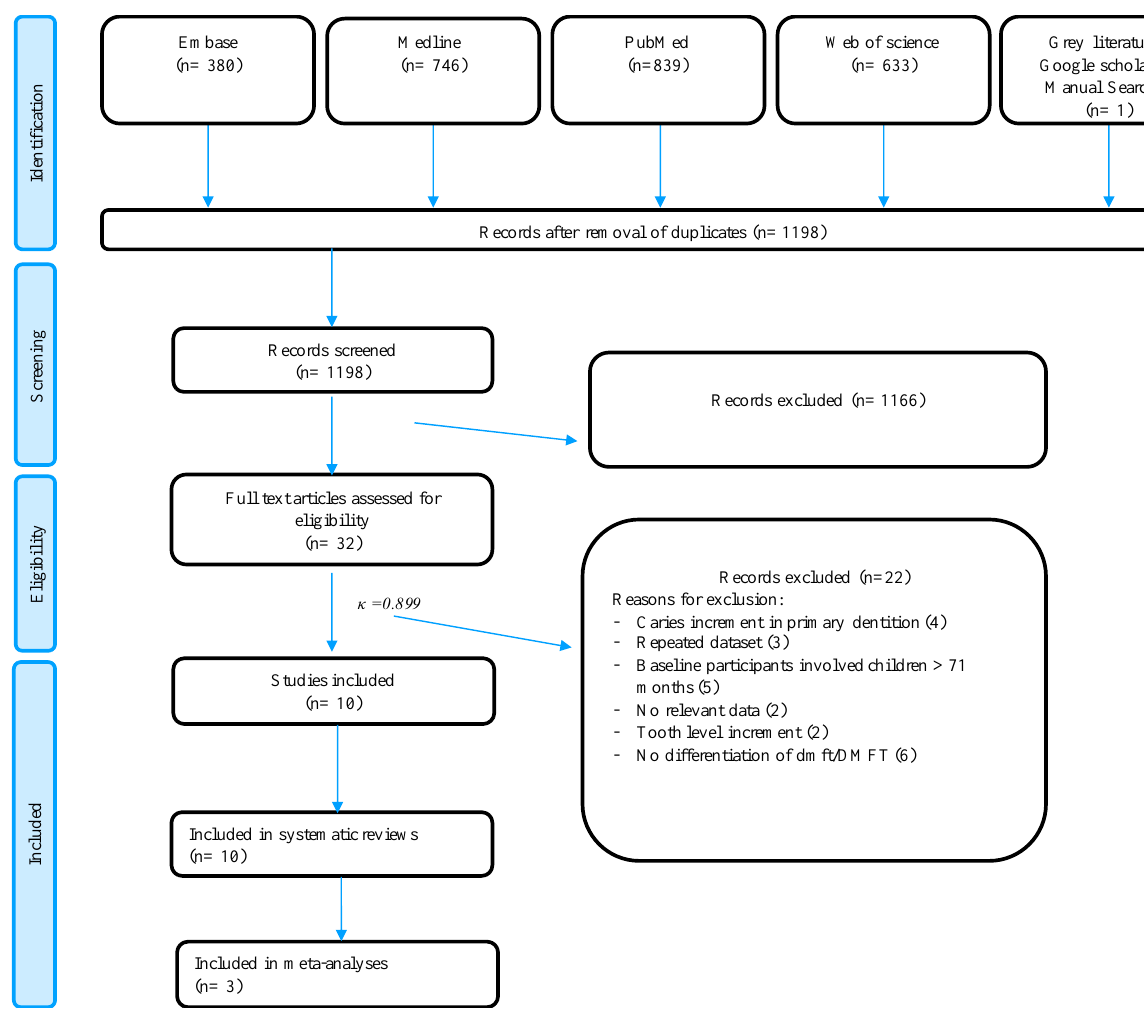
Figure 1. PRISMA flowchart of the current